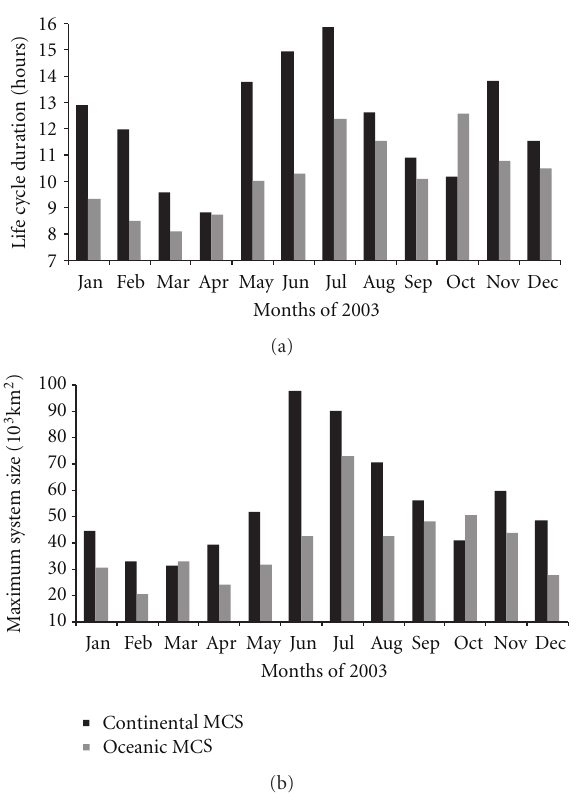
Figure 4: Continental and oceanic convective system characteris- tics: (a) Life cycle duration; (b) Maximum size area.